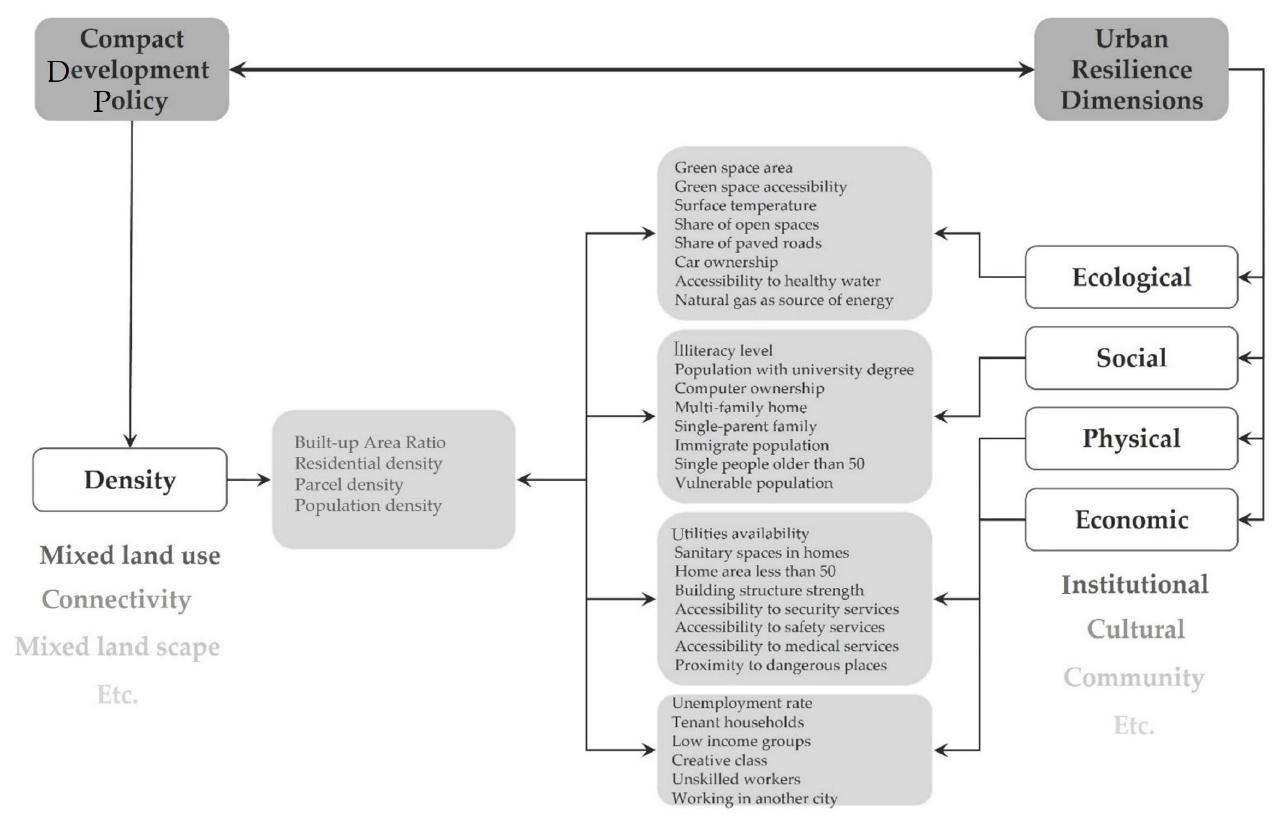
Figure 1. Conceptual model for evaluating a resilient city.